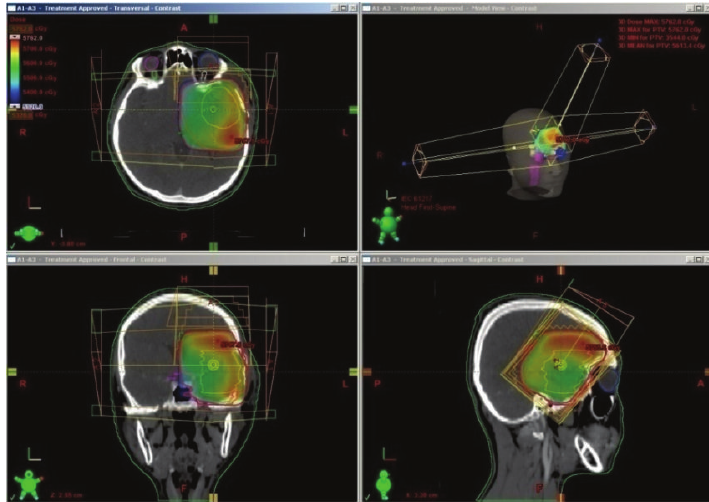
Figure 4: Radiotherapy was administered by 3D conformal technique and the dose wash shown in the figure.